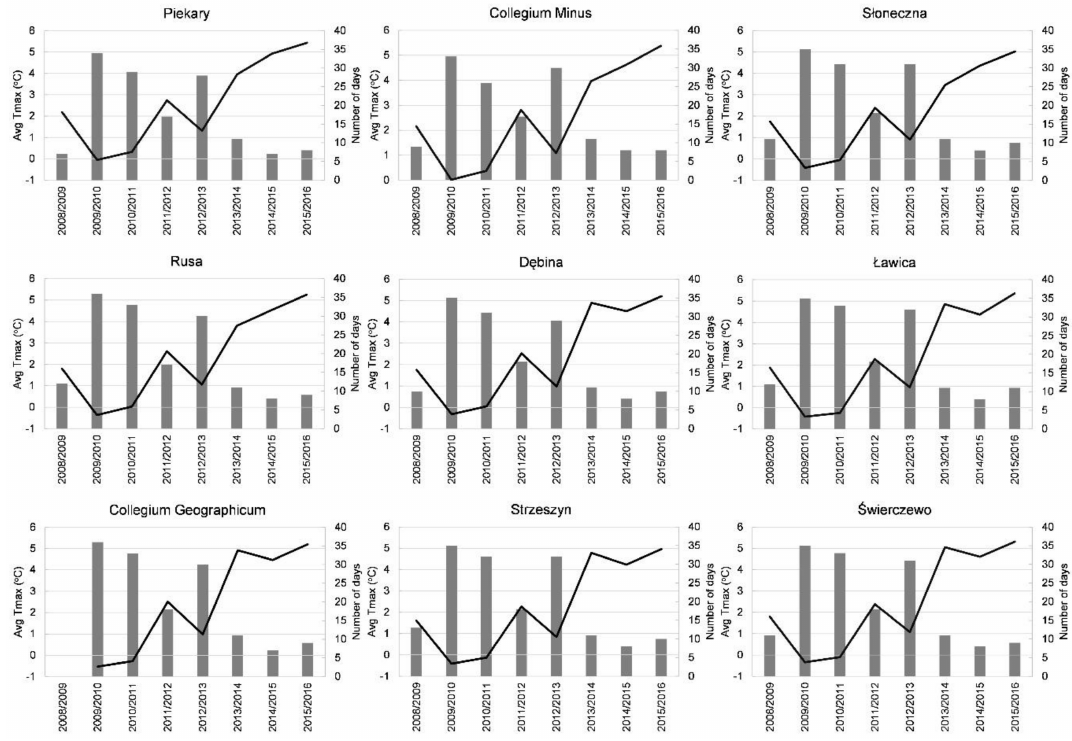
Figure 4. Average Tmax (black solid line) in the winter season and number of cold days (grey bars) in 2008/09–2015/16 in